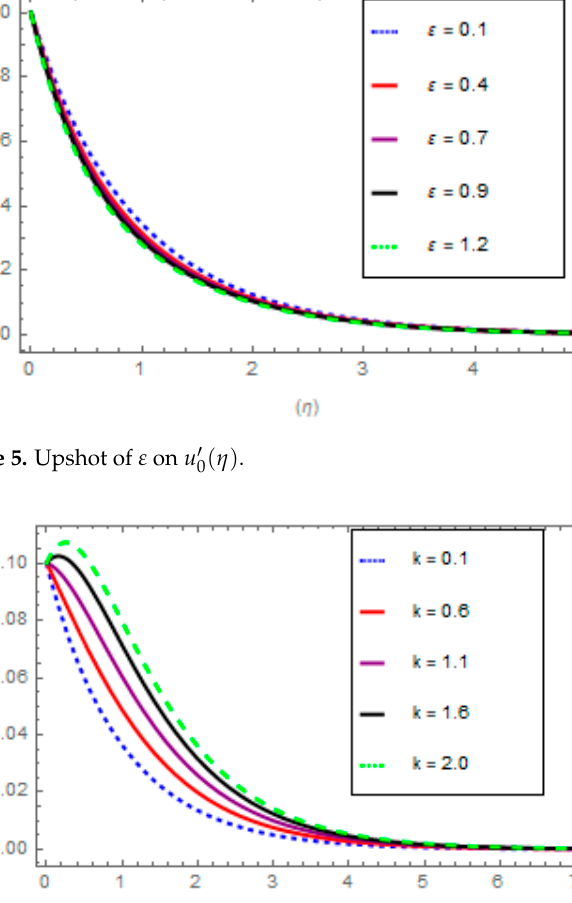
Figure 4. Upshot of M on u (cid:48)